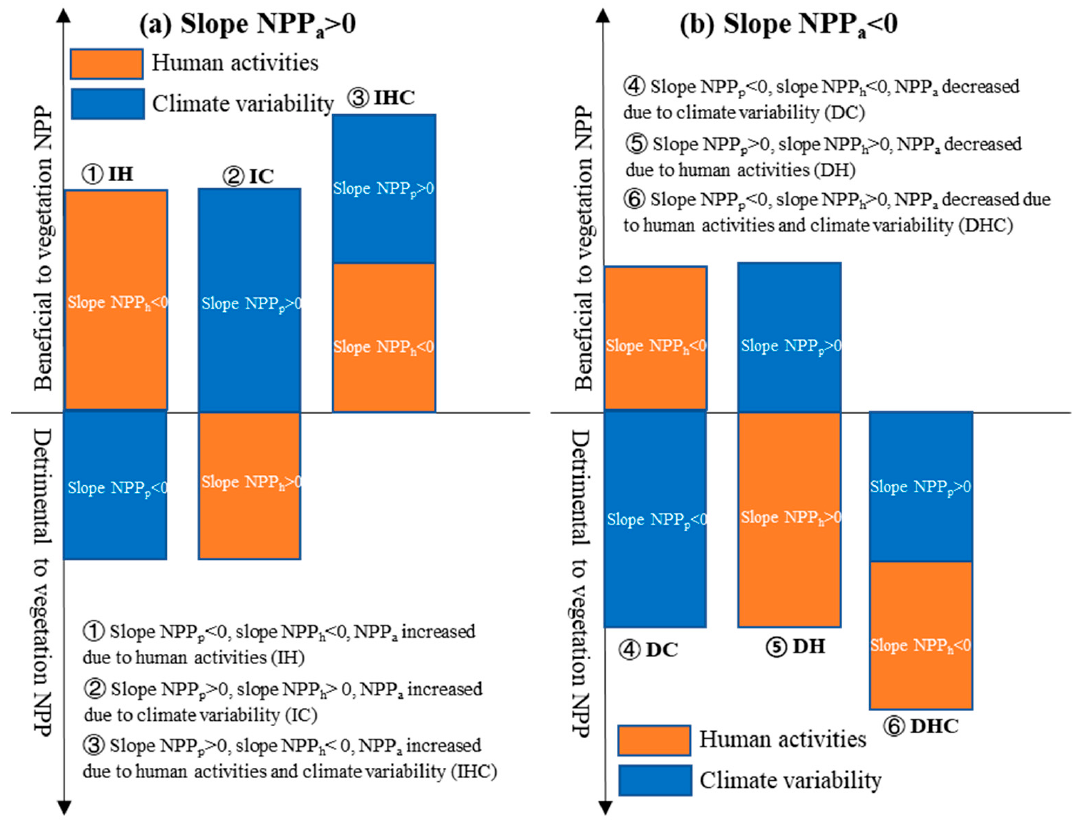
Figure 2. Identification of the relative impacts of climate variability and human activities on the NPP a according to the slopes of the NPP a , NPP p , and NPP h . Six scenarios are represented in ( a ) slope NPP a > 0 and ( b ) slope NPP a < 0.